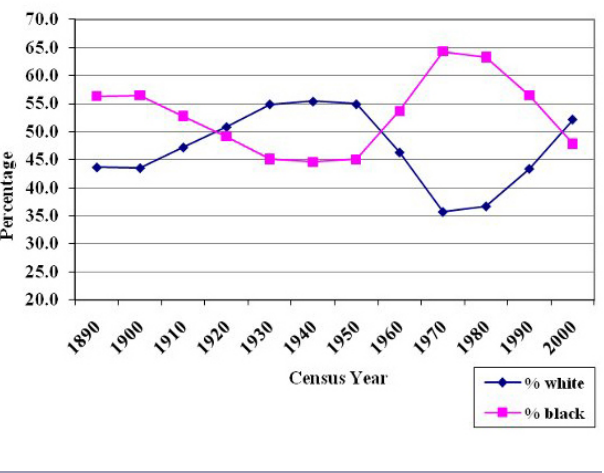
Fig. 3. Summary of population by race on Charleston’s peninsula, 1890-2000 (Source: Cutler et al. 1999, U.S. Census Bureau